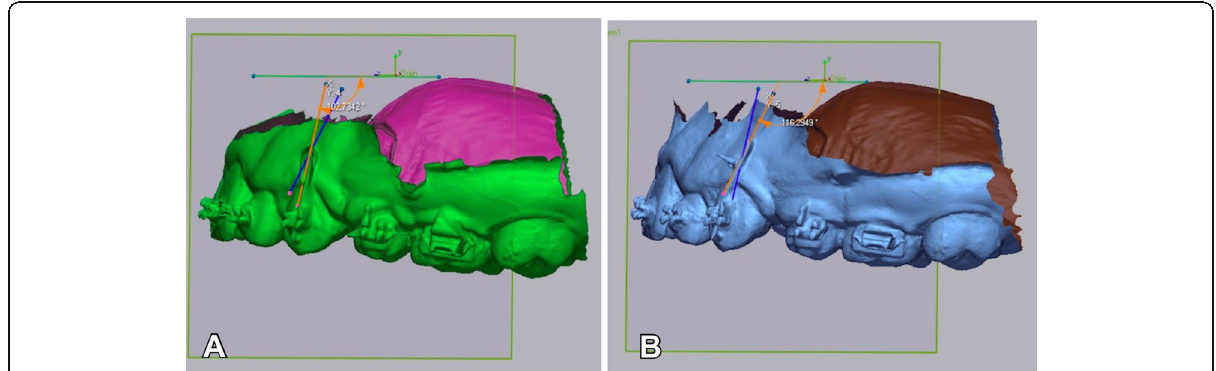
Fig. 5 The calculation of angulation changes using metal jigs on the vertical plane. A Angulation measurement in the T0 model. B Angulation measurement in the T3